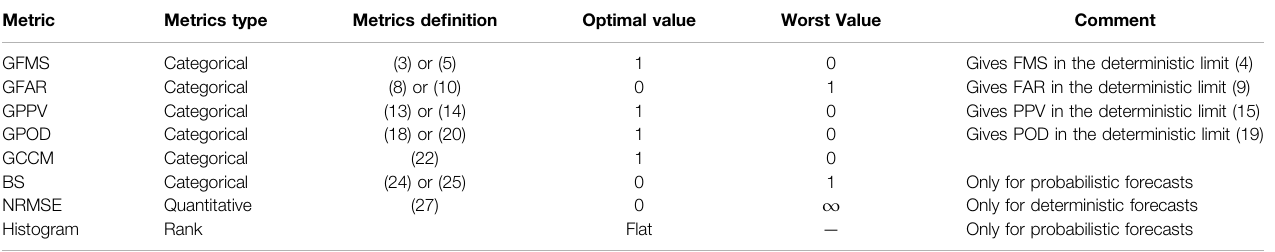
TABLE 3 | Summary of metrics. GMFS: Generalised Figure Merit of Space, GFAR: Generalised False Alarm Rate, GPPV: Generalised Positive Predictive Value, GPOD: Generalised Probability of Detection, GCCM: Generalised Composite Categorical Metric, BS: Brier Score, NRMSE: Normalised Root Mean Square Error.